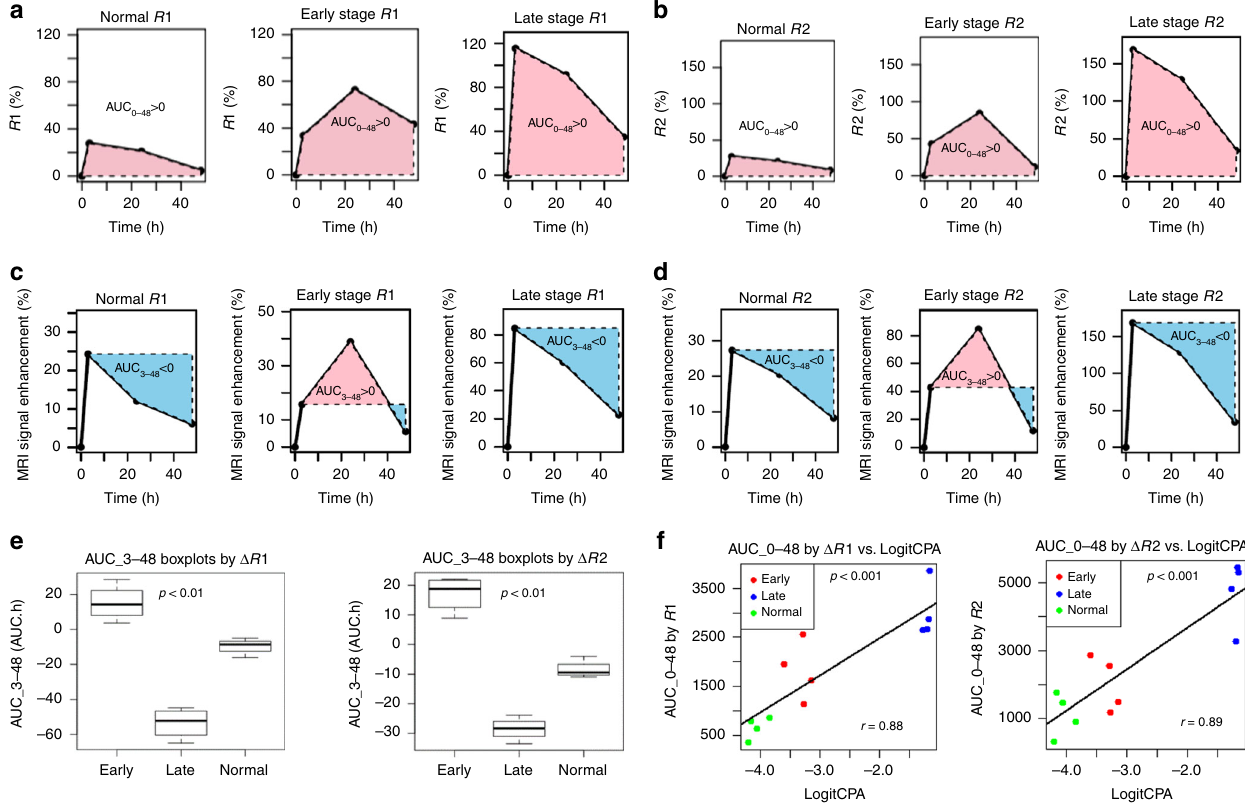
Fig. 6 Assessment of contrast agent uptake and staging of NASH and liver cirrhosis in NASH diet model. a, b Area under the curve (AUC_0 – 48 R1 and R2) analysis with ProCA32.collagen1 enhanced MR in NASH diet model. c, d Area under the curve (AUC_3 – 48 R1 and R2) analysis demonstrates the washout rate of ProCA32.collagen1 3 h post injection in late-stage fi brosis based on decreasing R1 and R2 values and negative value of AUC compared to normal liver and early stage fi brotic liver. e AUC_3 – 48 h boxplot analysis demonstrating the ability of ProCA32.collagen1 to distinguish normal vs. early stage NASH and early stage NASH vs. late-stage fi brosis in NASH diet model ( P < 0.01, unpaired two-tailed student ’ s t test; the midline is the median of the data, with the upper and lower limits of the box being the third and fi rst quartile, 75th and 25th percentile, respectively. The whiskers extends up to 1.5 times the interquartile range and show the minimum and maximum as they are all within that distance). f Scatter-plots of Logit-transformed CPA against AUC_0 – 48 showed that AUC_0 – 48 and CPA levels are well correlated in NASH diet model. P < 0.001, unpaired two-tailed student ’ s t test; all data are represented as mean ± SD, n = 4 biologically independent animals in each